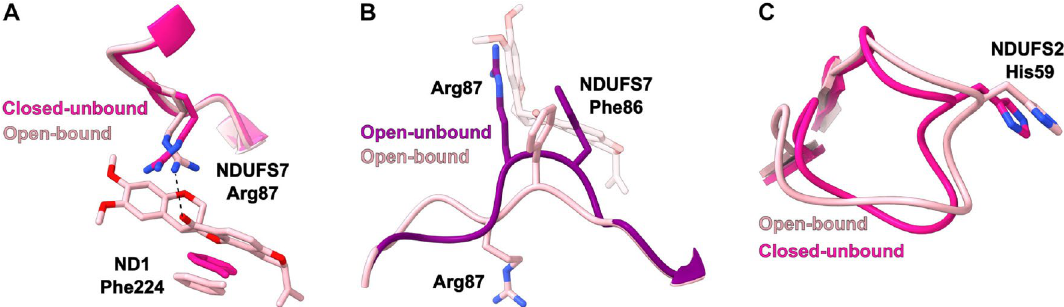
Figure 3. Rotenone-induced conformational changes in ( A ) ND1 Phe224 and NDUFS7 Arg87 side-chains near the ROT2 binding mode, ( B ) NDUFS7 Arg87 loop near the pre-redox mode, and ( C ) NDUFS2 β 1- β 2 loop near the ROT1 mode. Panels ( A ) and ( B ) show a rotenone obtained from simulations in the ROT2 and pre-redox modes, respectively. Closed-unbound corresponds to PDB 6ZKG 8 and is equivalent to other closed cryoEM models without ligands inside the Q-channel, such as PDB 6ZR2 22 used to start the simulations here. Open-unbound corresponds to PDB 6ZKS 8 , which has a disordered NDUFS2 β 1– β 2 loop similar to other open cryoEM models 15 . Open-bound corresponds to PDB 6ZKL 8 , with rotenone bound in both ROT1 and ROT2